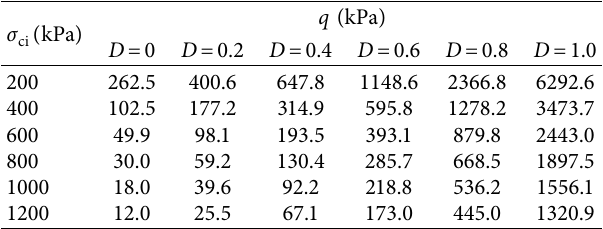
Table 6: Upper bound solution of the surrounding rock pressure e at different GSI and m i .